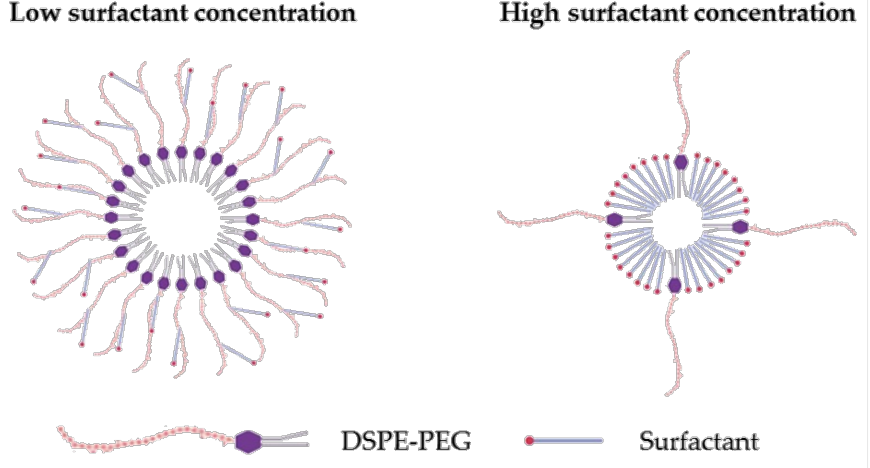
Figure 4. Sketch of the di ff erent types of aggregates obtained as function of the surfactant concentration.